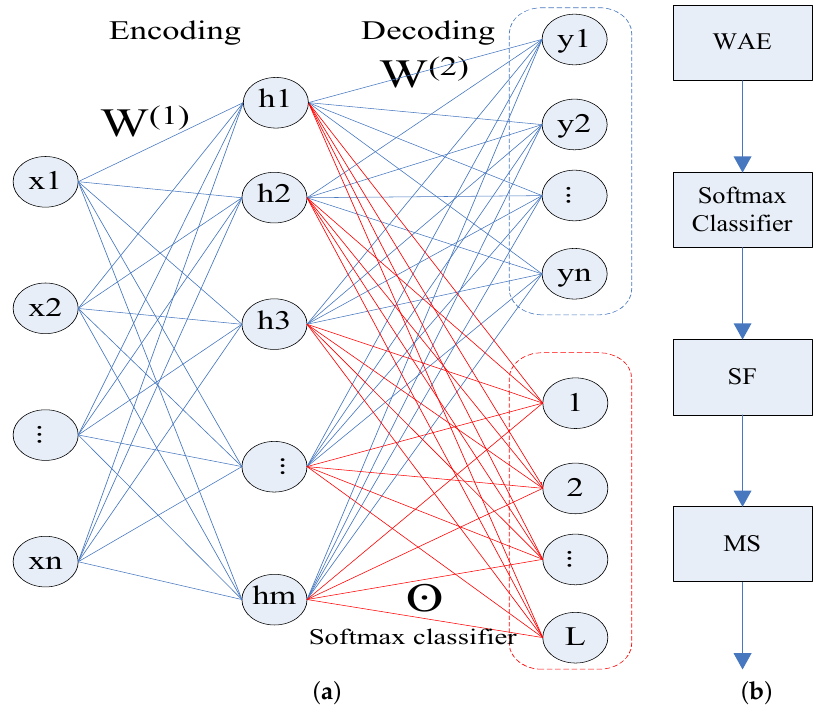
Figure 2. ( a ) The network with blue box is the structure of the WAE, while that with red box is the combination of the WAE and Softmax classifier; and ( b ) the flow chart of all steps of the proposed classification